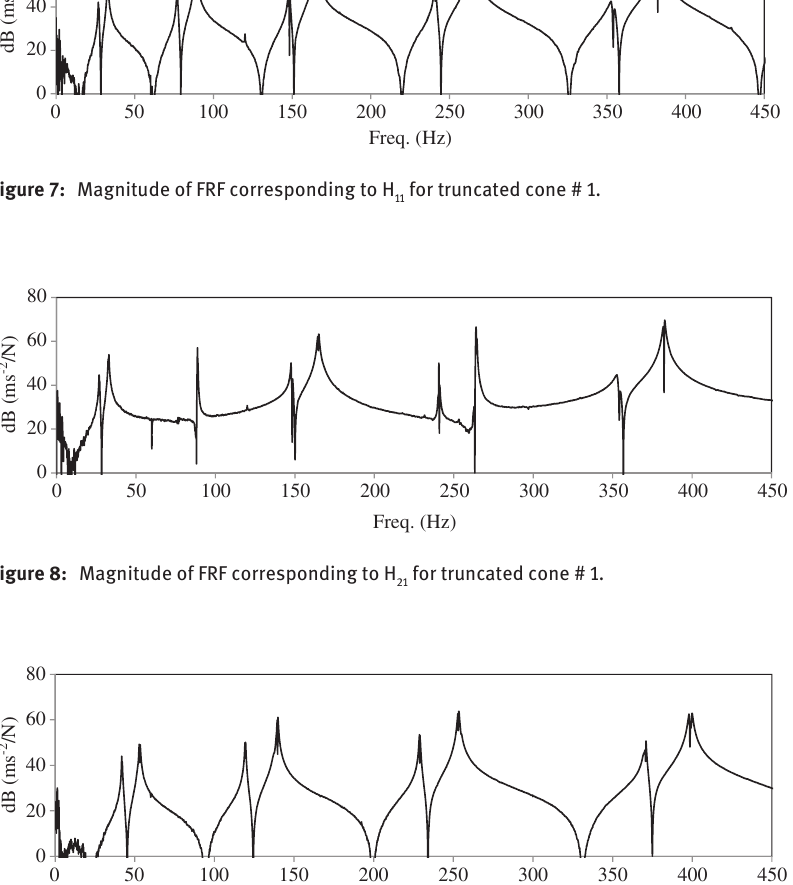
Figure 9: Magnitude of FRF corresponding to H